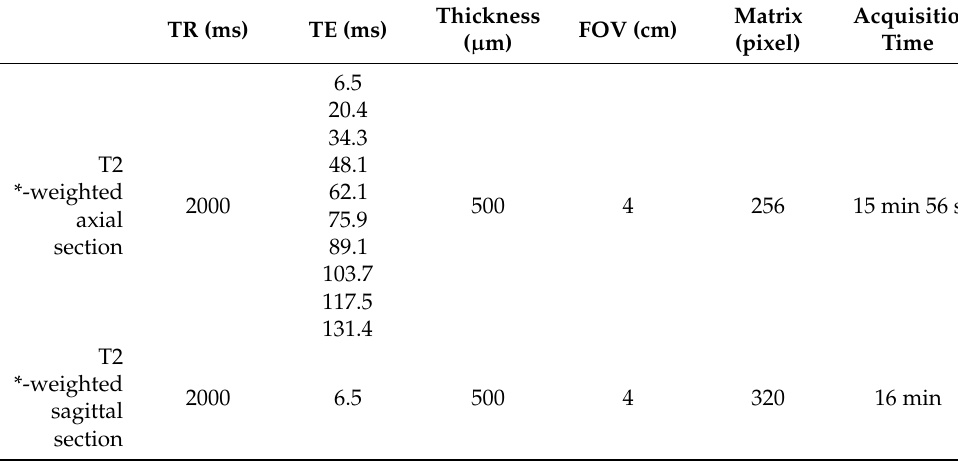
Table 1. Summary table of the acquisition parameters of MRI sequences used to characterize and identify spinal cord structure on rats after SCI and/or rTSMS treatment. TR (ms) TE